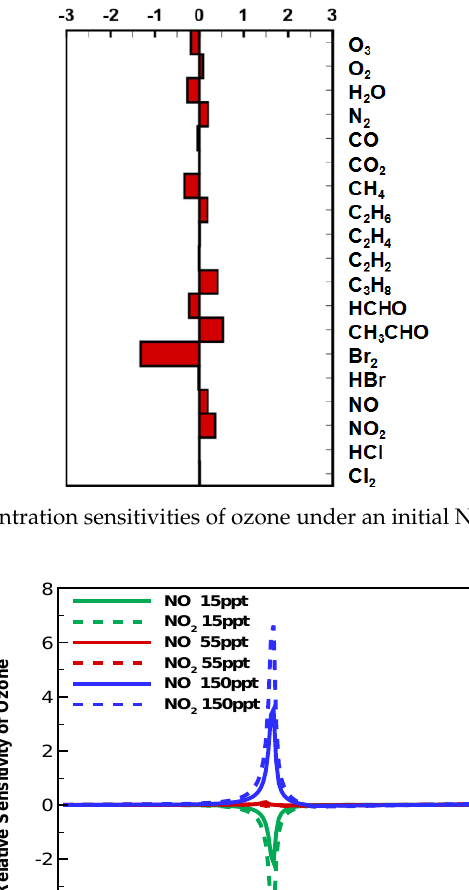
Figure 8. Temporal change of the relative concentration sensitivities of ozone to the initial NO (solid) and NO (dashed) under an initial NO of 15ppt (green curve), 55ppt (red curve) and 150ppt (blue 2 x